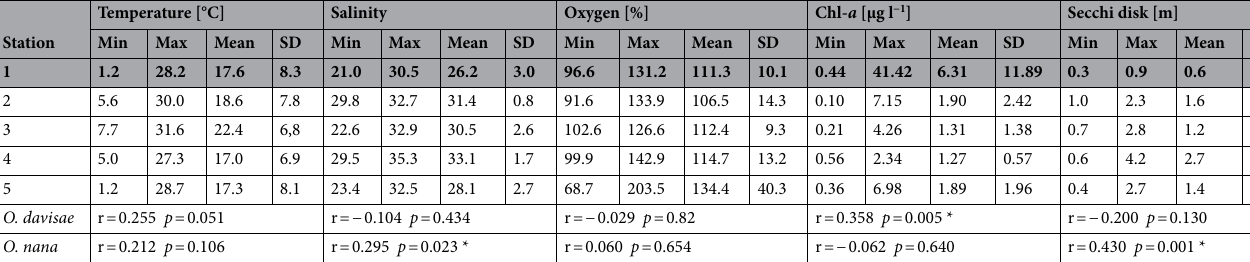
Table 2. Minimum, maximum, mean and standard deviation of the temperature, salinity, oxygen, chlorophyll a and Secchi disk values measured at lagoon stations and Pearson correlations values for the two Oithonidae and the environmental parameters.